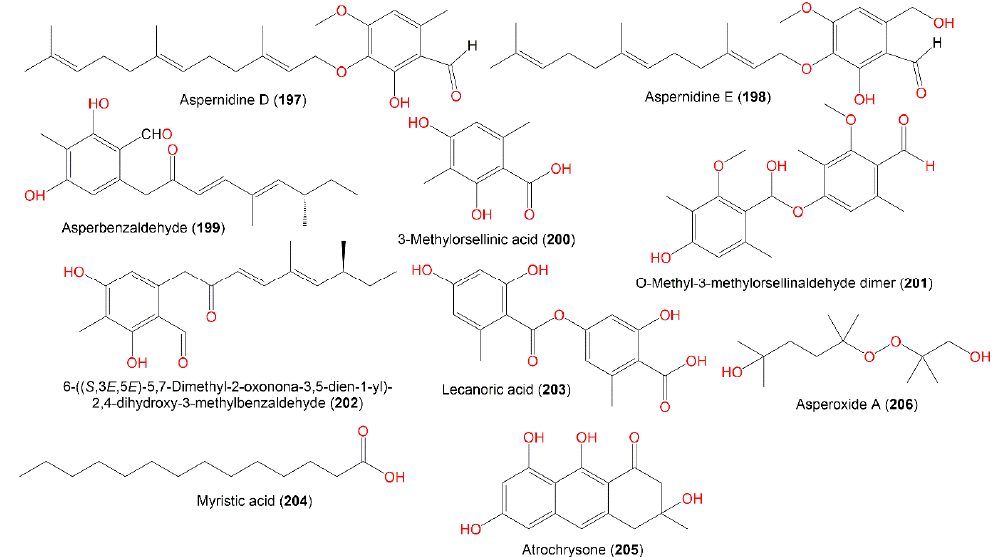
Figure 20. Structures of other metabolites ( 197 – 206 ). Table 14. Other metabolites reported from A. nidulans . The extract of E. nidulans var. acristata displayed cytotoxic potential versus different cell lines (mean IC 70 of 8.30 μ g/mL) [43]. A. nidulans EtOAc extract culture broth had only moderate antibacterial effectiveness versus B. megaterium [47]. It also (Conc. 30 μ g/disc)